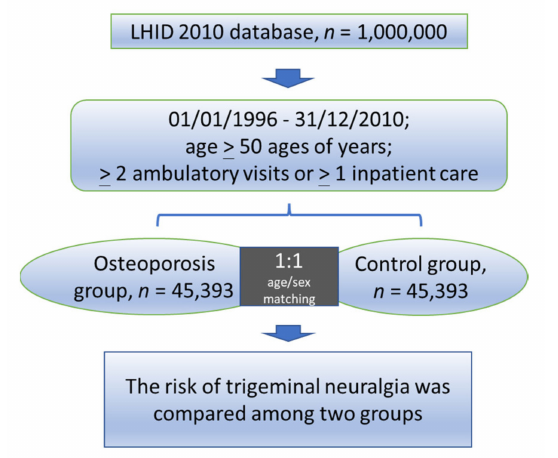
Figure 1. Flow diagram of the study. LHID = Longitudinal Health Insurance